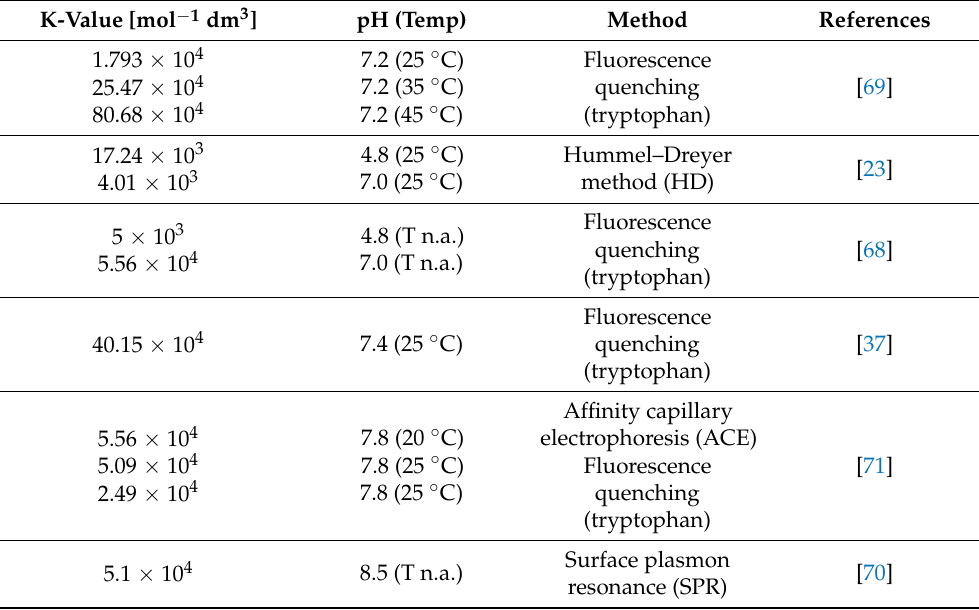
Table 1. Overview of the binding capacities for FA and BSA and the corresponding